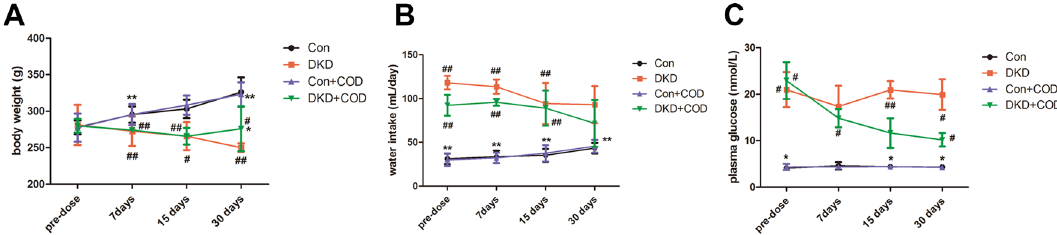
Fig. 1 Effect of COD on body weight, water intake, and fasting blood glucose of DKD model (n = 6). All data were presented as the mean ± standard deviation. ## p \ 0.01, # p \ 0.05 vs. Con group; ** p \ 0.01, * p \ 0.05 vs. COD